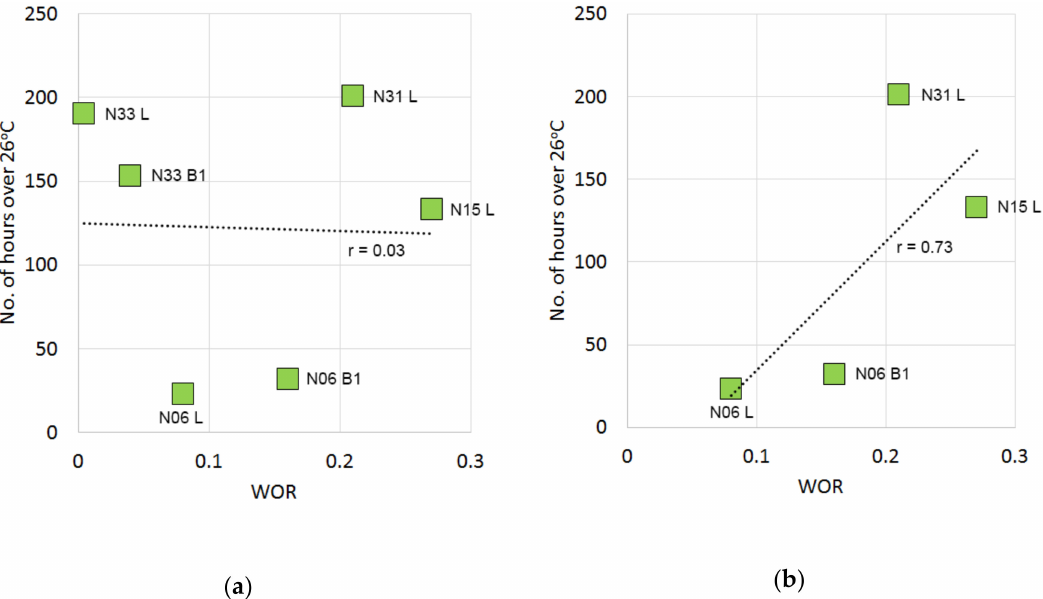
Figure 13. High temperature hours vs. living room window opening ratio (WOR): ( a ) Flats N31, N33, N15, N06; ( b ) Flats N31, N15, N06.